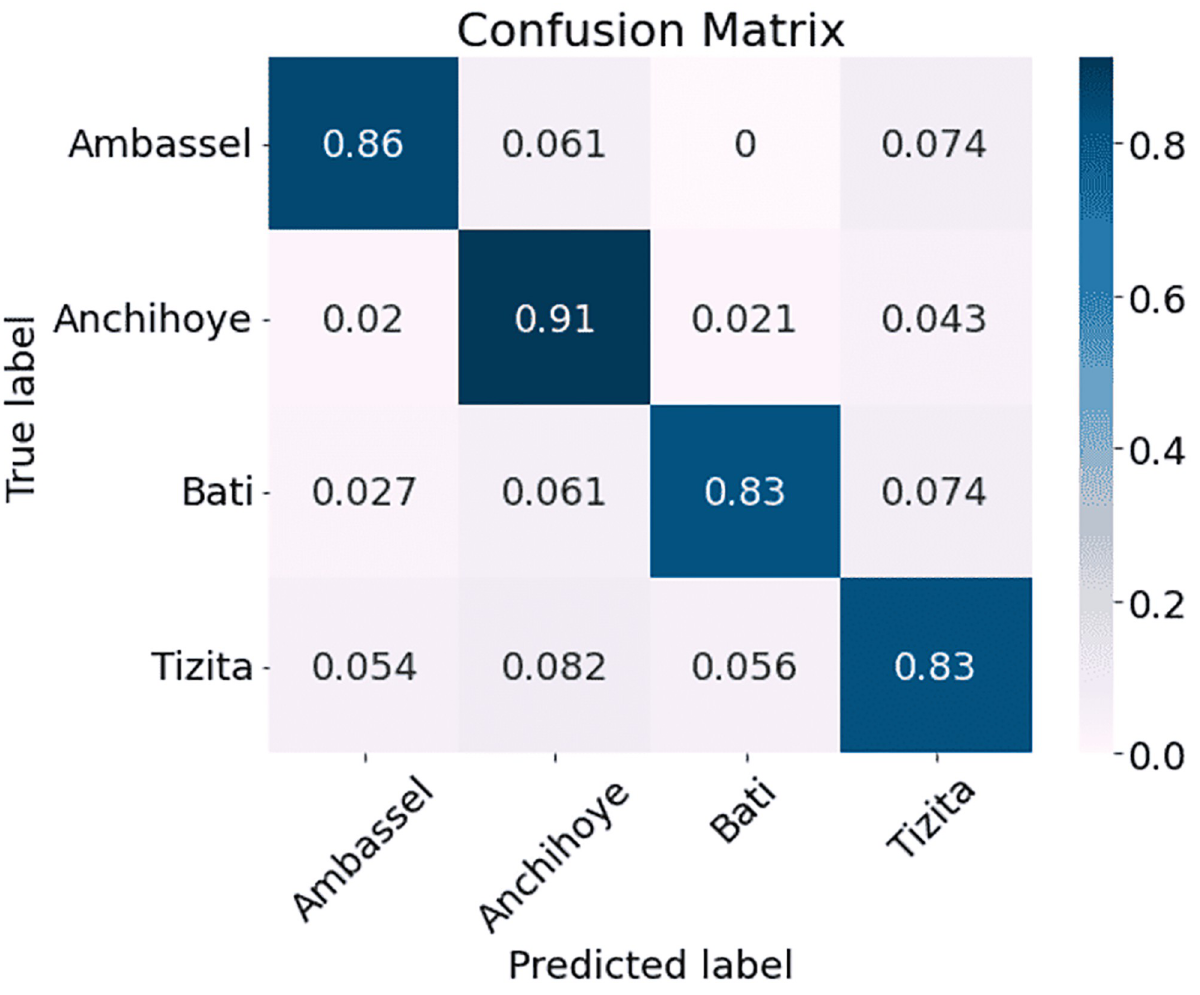
Fig 4. Experiment 1: EKM confusion matrices using Chroma on